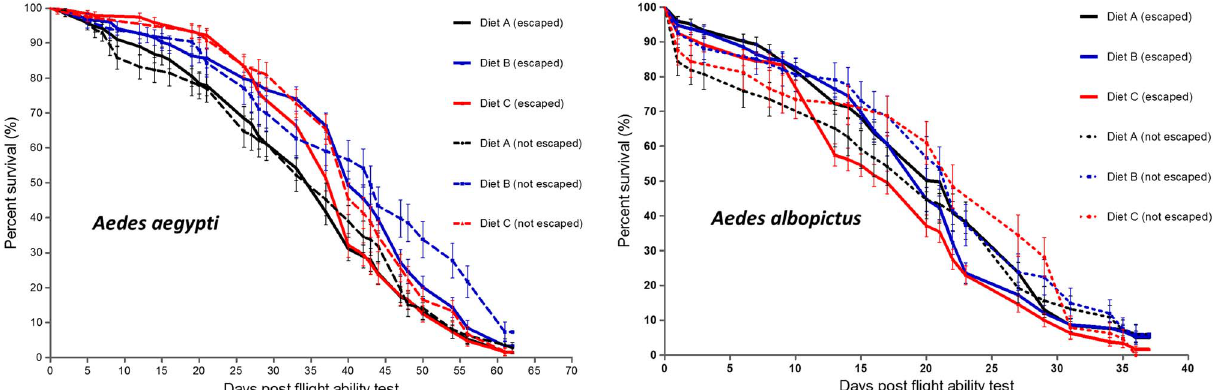
Figure 5. Longevity post fl ight ability test of male Aedes aegypti and Aedes albopictus reared from L1 with different larval diets. Diet A = 50% TM + 35% BLP + 15% BY, Diet B = 50% TM + 35% BSF + 15% BY, Diet C = 50% TM + 50%